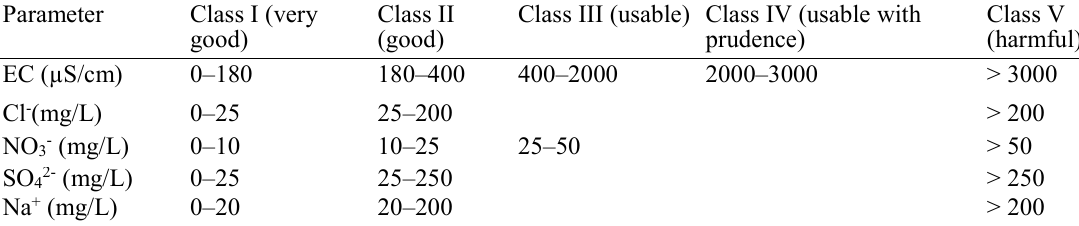
Table 2 Drinking water classification (Neubert et al.